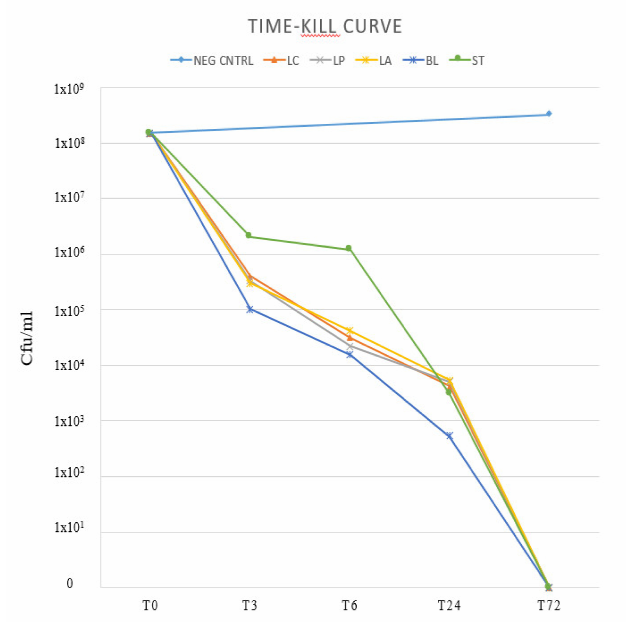
Figure 4. Time-kill curve. One multi-resistant H. pylori strain was co-incubated with supernatants derived from overnight broth culture of each probiotic strain. After only 3 h of incubation, H. pylori viable cell count decreased from 10 8 to 10 6 –10 5 CFU / mL: CFU: colony-forming units. LC: L. casei . LP: L. paracasei . LA: L. acidophilus . BL: B. lactis . ST: S. thermophilus